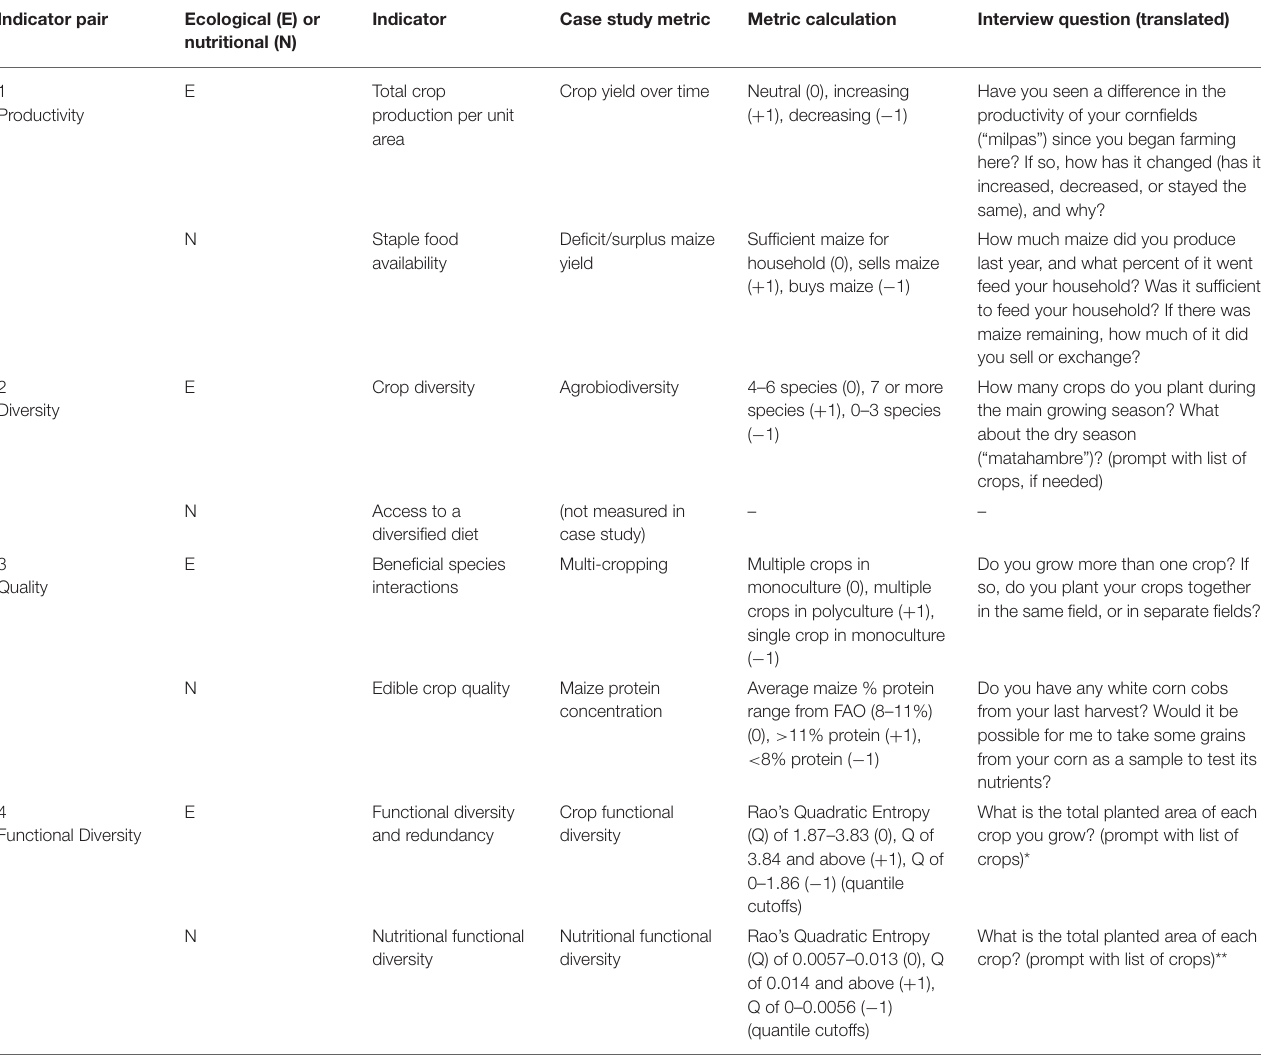
TABLE 2 | Indicators of ecological and nutritional functions applied to a case study of smallholder agroecosystems in eastern Guatemala. Indicator